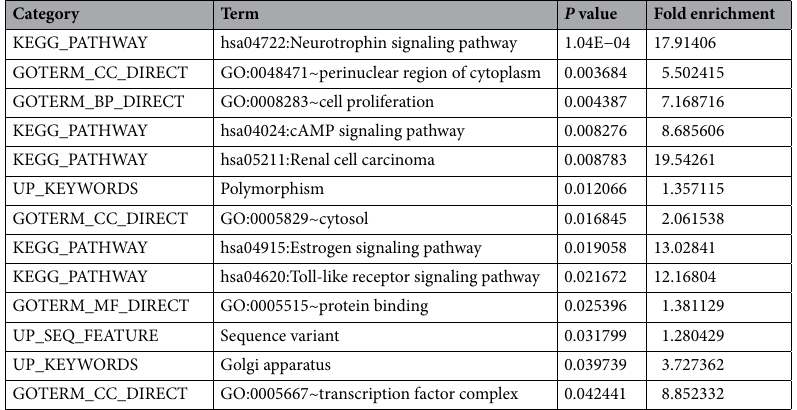
Table 4. Functional annotation using chart tool of